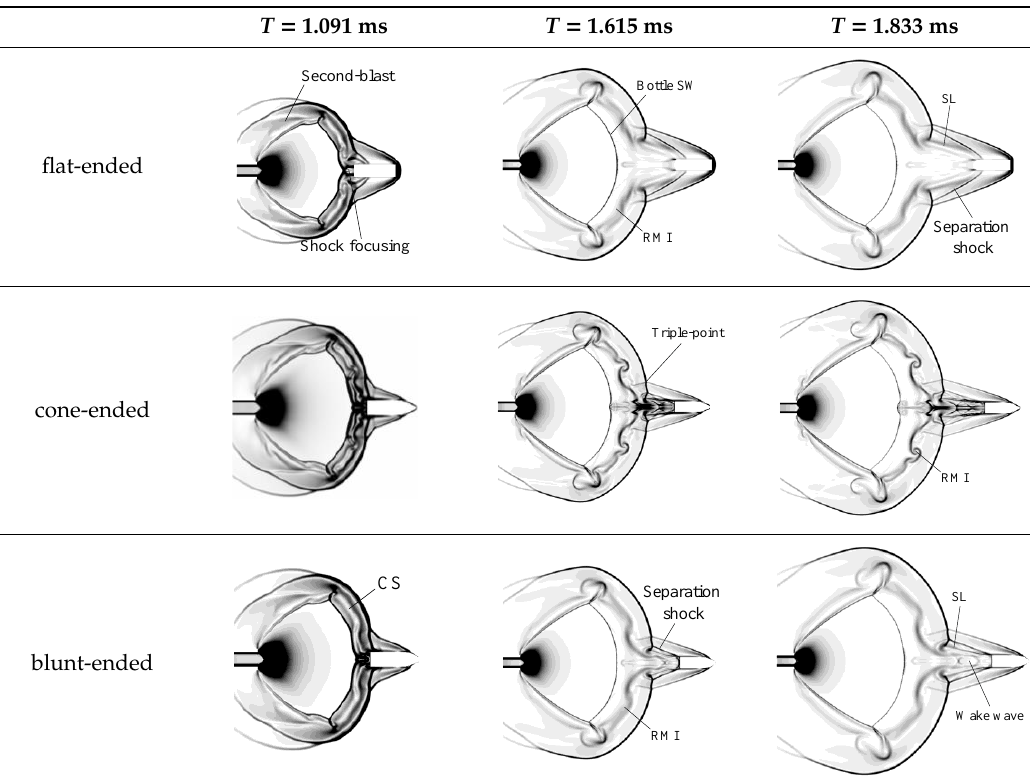
(d) Figure 8. Bow shock-wave development process ahead the projectile. ( a ) t = 0.590 ms; ( b ) t = 0.671 ms; ( c ) t = 0.736 ms; ( d ) t = 0.989 ms.